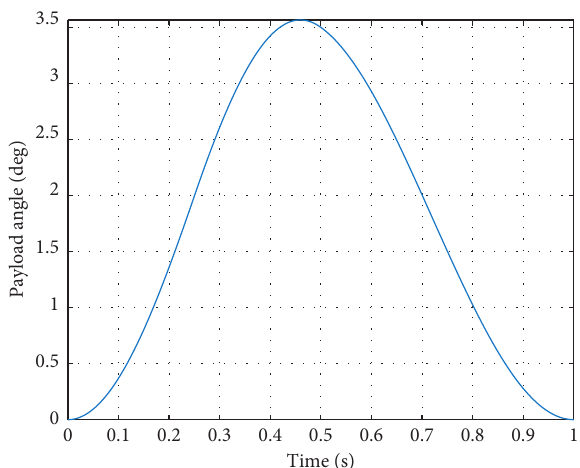
Figure 2: Payload angle versus maneuver time for a specific cable length.